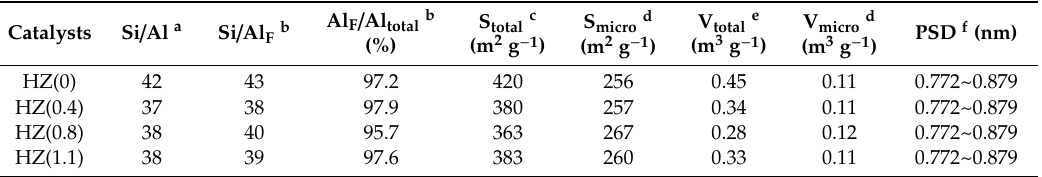
Table 2. Elemental composition, textual properties and Al distribution of HZSM catalysts with different Na/Al ratios in synthesis gels.